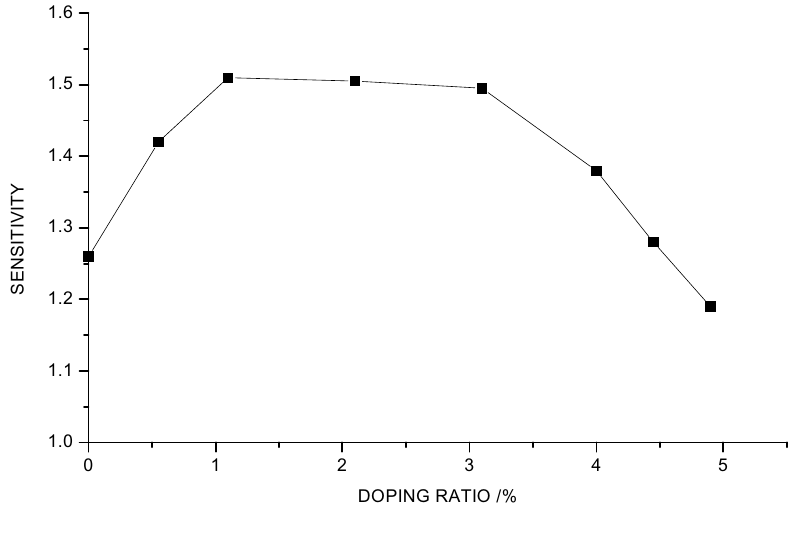
Figure 3. Dependence of sensor sensitivity to CO